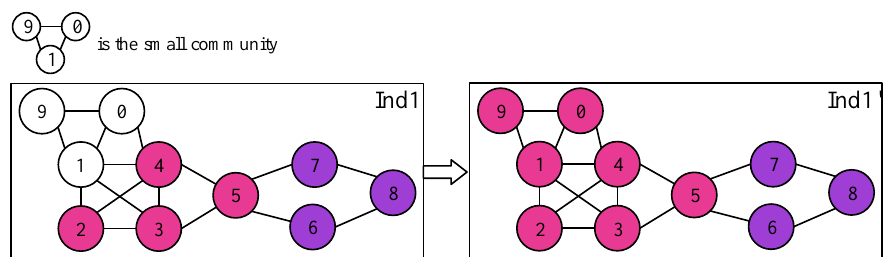
Figure 8. Community